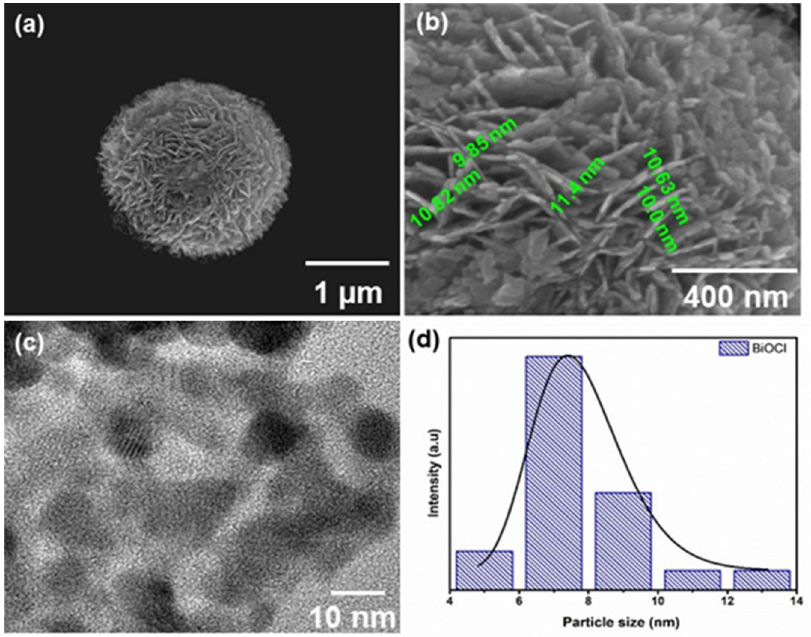
Figure 4. SEM ( a , b ) and TEM ( c ) images and distribution of particle size ( d ) of BiOCl photocata- lyst.